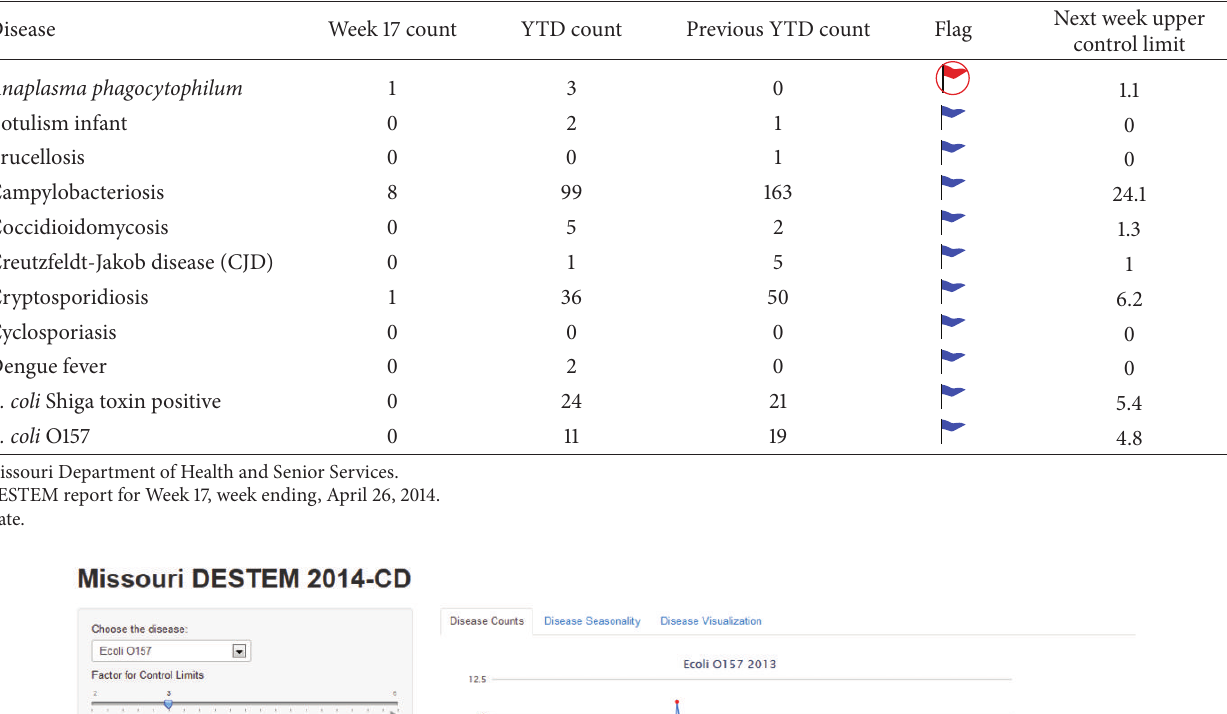
Table 1: A portion of the weekly report for the week ending April 26, 2014, showing the status of just the first eleven diseases. The red flag (circled) indicates a point above the upper control limit. Altogether, there were three “red flags” for this week, with the other two not shown in this table.